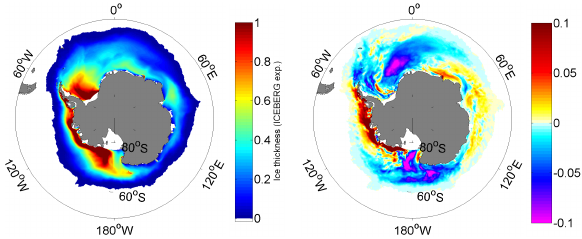
Figure 5. As Fig. 4, for sea ice thickness (defined here as the mean ice thickness of the ice-covered part of a grid